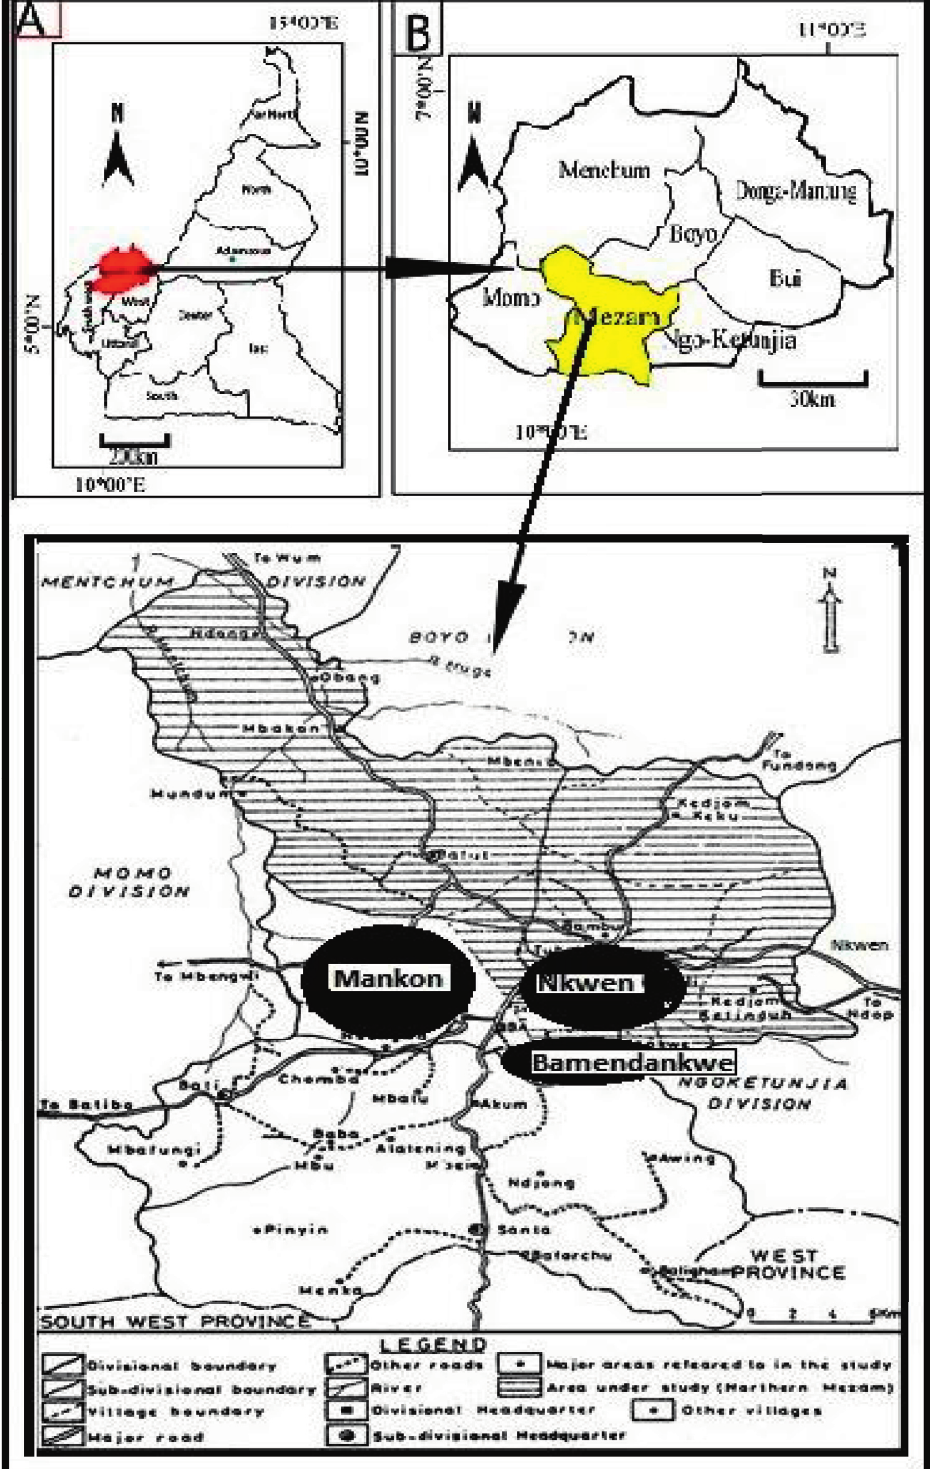
Figure 1: Map of the northwest region showing the study area and the different sampling sites (Bamenda City Council Development Plan,